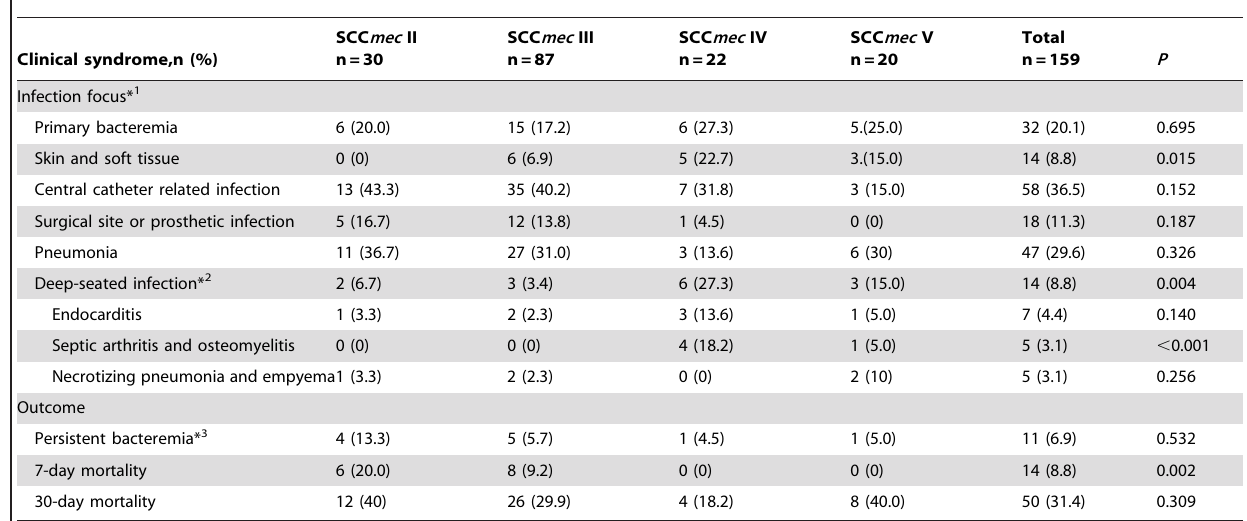
Table 2. Comparison of clinical characteristics and outcomes of MRSA bacteremia patients with different SCCmec types.